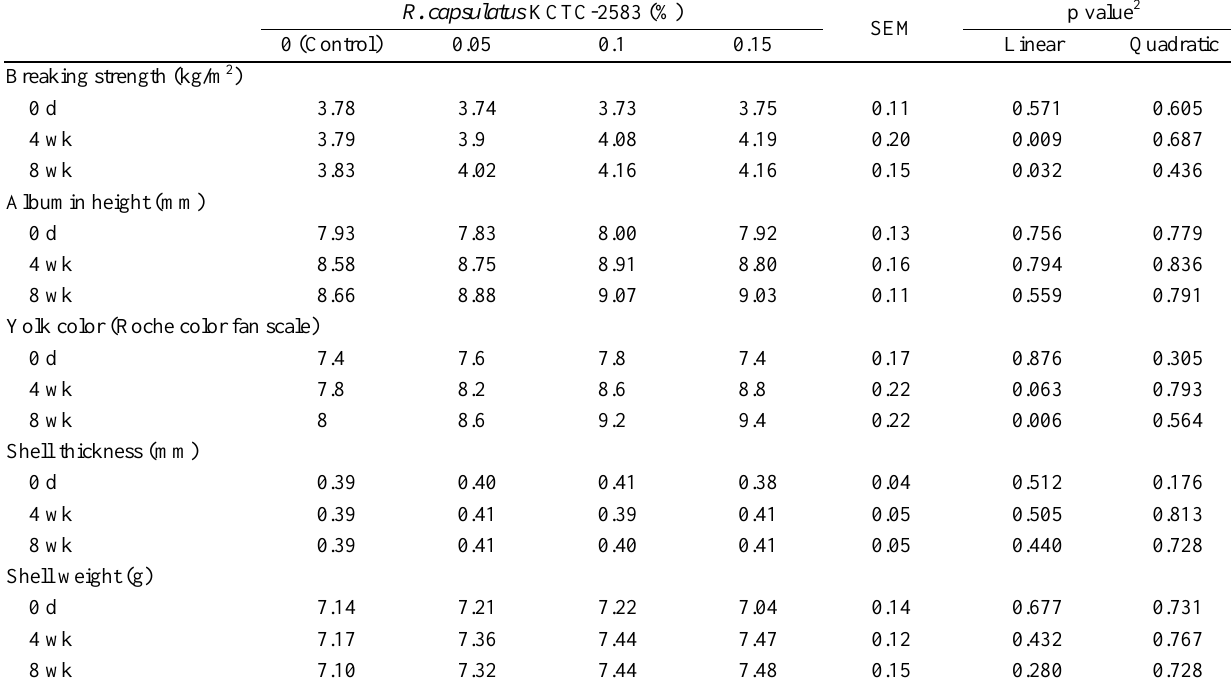
Table 5. Effects of dietary Rhodobacter capsulatus KCTC-2583 on egg quality (breaking strength, albumin height, shell thickness, yolk colour and shell weight) at different interval in laying hen